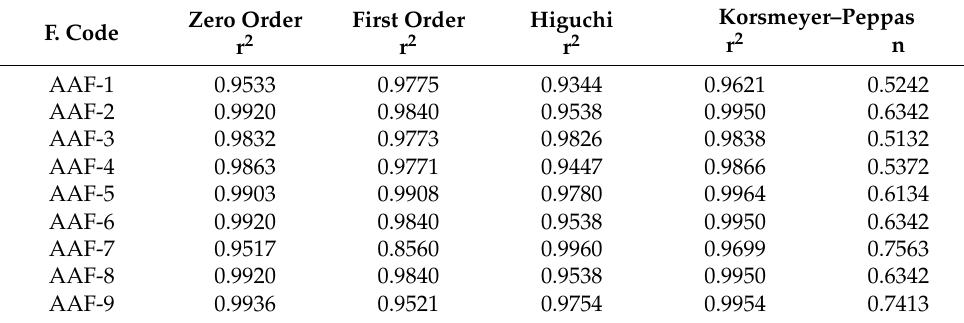
Table 2. Kinetic modeling release of drug from ASP/ALPAA hydrogels.